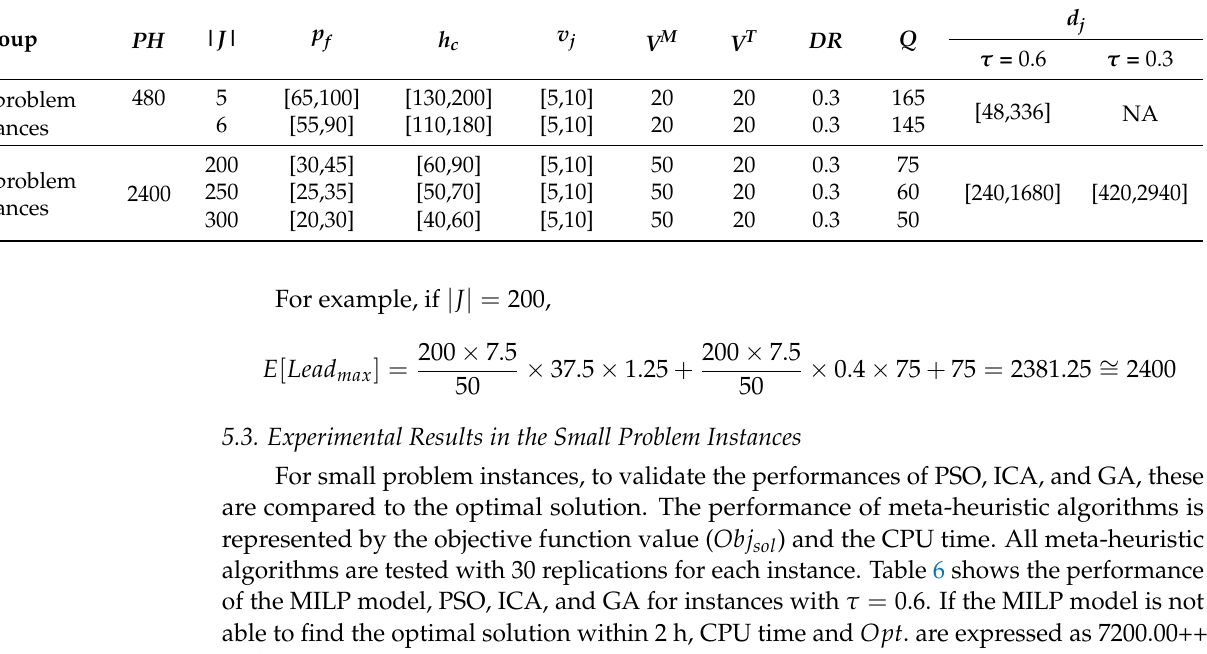
Table 5. Problem parameter